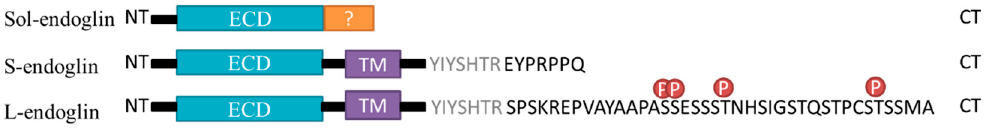
Figure 2. A schematic of endoglin structure. The soluble endoglin (sol-endoglin), short isoform endoglin (S-endoglin) and long isoform endoglin (L-endoglin). Relevant domains such as the extracellular domain (ECD), transmembrane domain (TM), cellular domain (CD) and phosphorylation sites by TGF- β II and ALK1 are indicated.